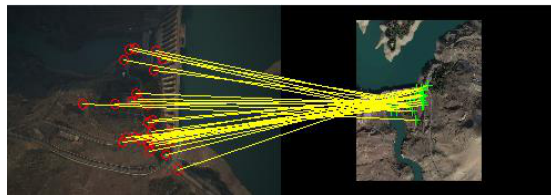
Figure 6. The results of matching process for selected UAV image frame against to database; left: UAV image frame and right: reference image